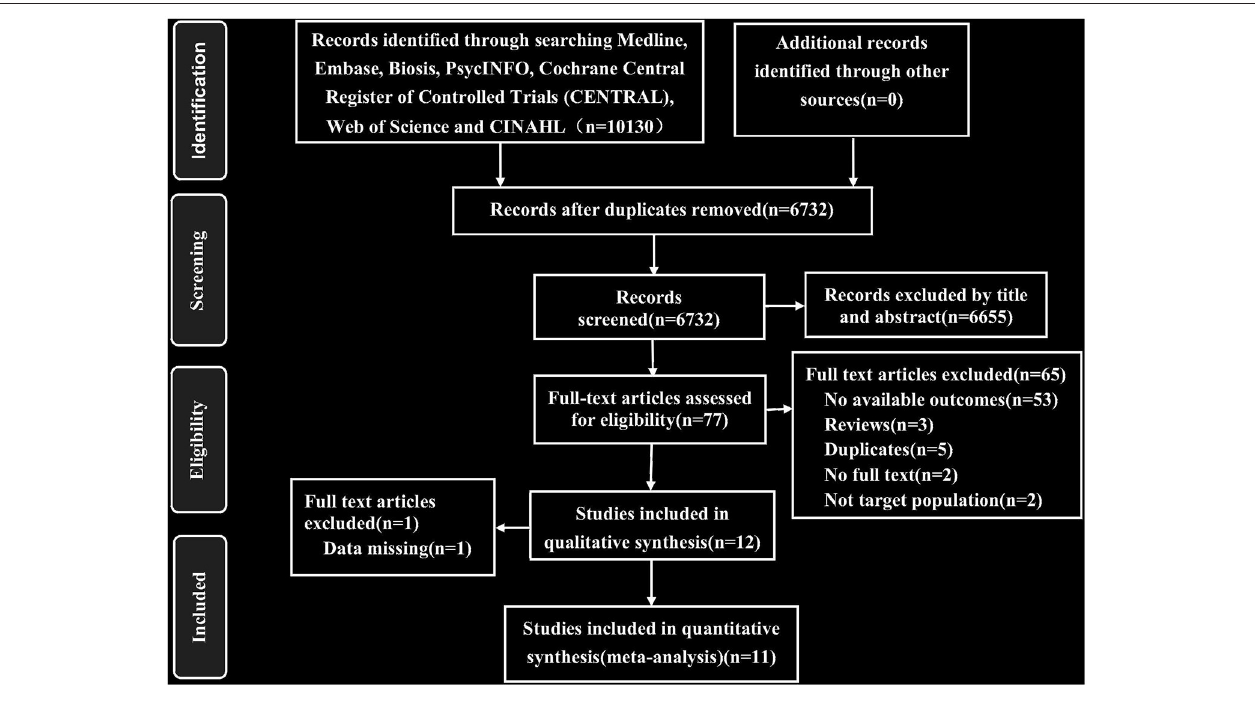
FIGURE 1 | The flowchart of study selection.